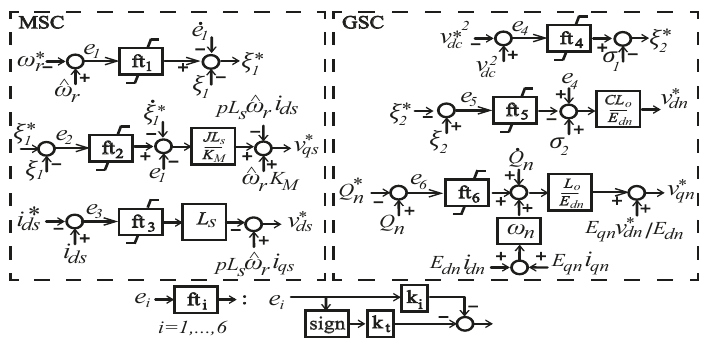
Figure 3. Block diagram of the proposed FTC.